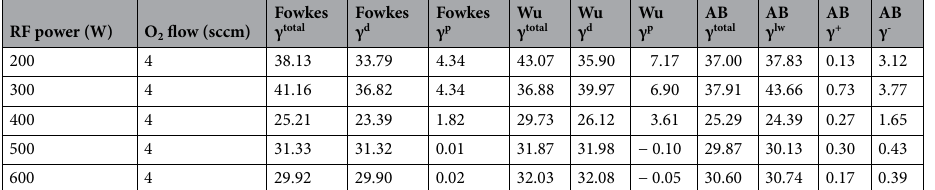
Table 7. The Fowlkes, Wu, and AB Surface Energy terms in mJ/m 2 for Copper Oxide films compared at different rf Power and 4 sccm oxygen flow.